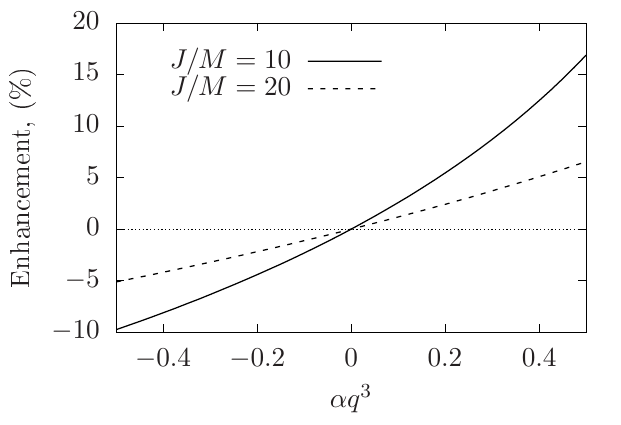
Figure 4. Percentage of bending-angle enhancement over standard GR, for impact parameters J / M = 10 and J / M =